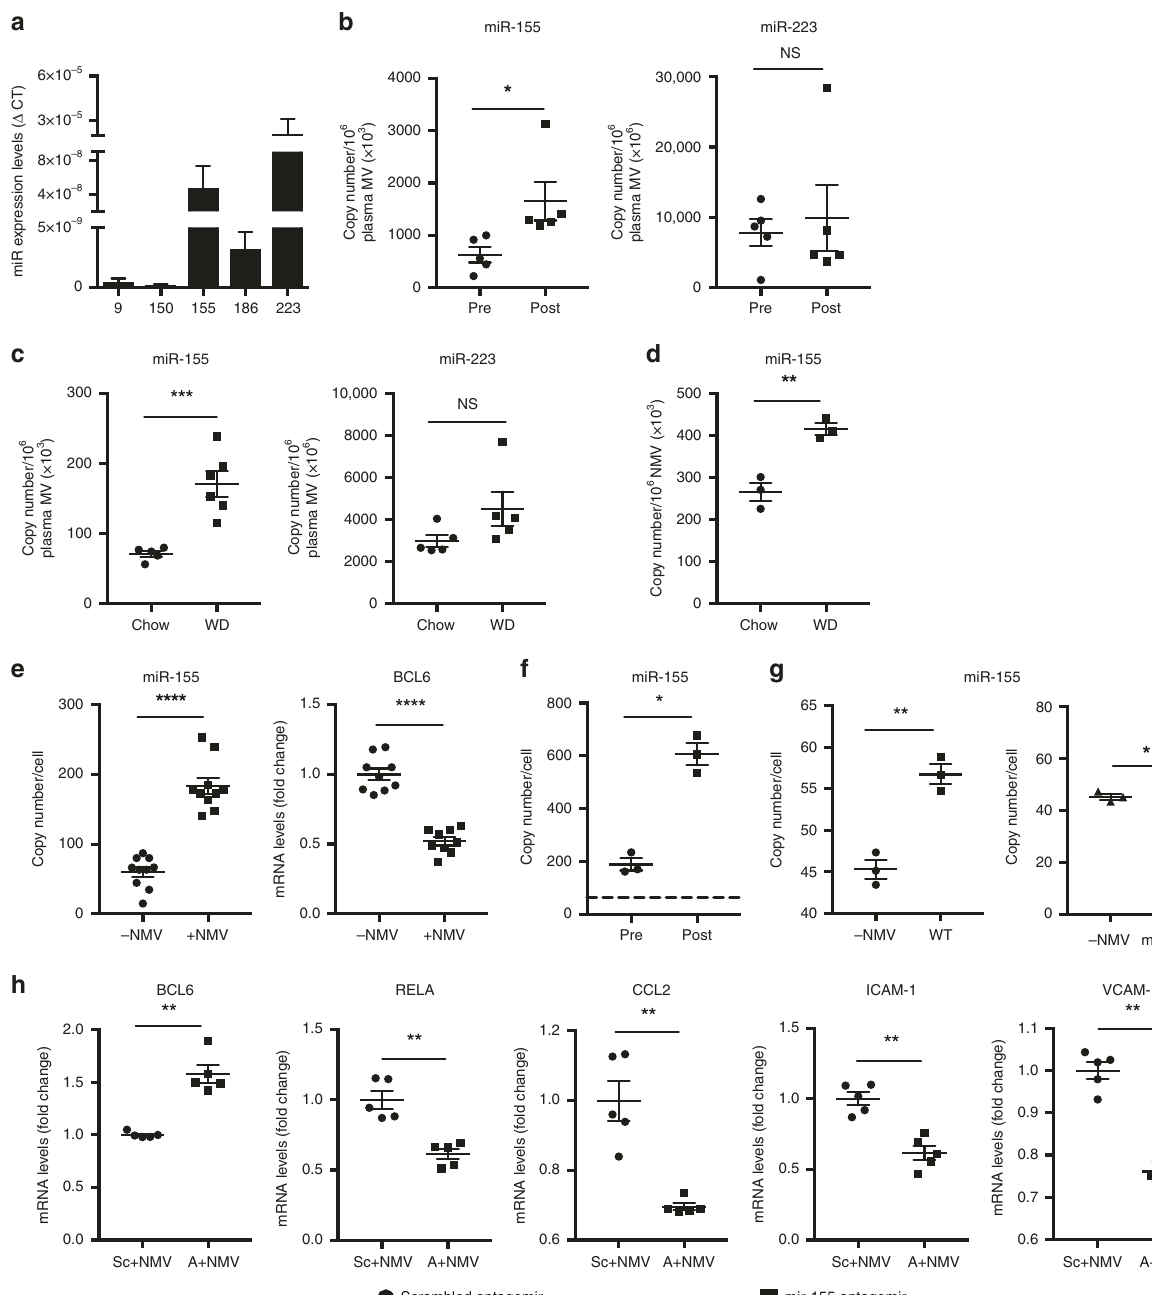
Fig. 6 NMVs contain miRNAs that are delivered to HCAEC and alter gene expression. a miRNA content of NMVs prepared from stimulated human neutrophils quanti fi ed by RT-qPCR ( n = 5). b miR-155 and miR-223 content of MVs in human plasma pre- and post high-fat diet (HFD, n = 5), or ( c ) plasma from mice fed chow or Western diet (WD, 6 weeks; n = 5) was quanti fi ed by RT-qPCR. d miR-155 expression levels in NMVs isolated from mice fed chow or Western diet ( n = 3) was measured by RT-qPCR. e HCAEC were incubated with ( + NMV) or without ( − NMV) NMVs for 2 h and miR-155 ( n = 10) and BCL6 ( n = 9) expression levels measured by RT-qPCR. f HCAEC were incubated with NMVs prepared from human neutrophils isolated pre- and post HFD and miR-155 expression levels quanti fi ed by RT-qPCR ( n = 3). The dotted line shows the mean copy number per HCAEC in the absence of NMVs. g HCAEC were incubated with NMVs prepared from miR-155 − / − vs. wild type mouse neutrophils and miR-155 expression levels quanti fi ed by RT-qPCR ( n = 3). h HCAEC were transfected with 25 ρ mol of miR-155 antagomir (A) or scrambled control (Sc) and incubated with NMVs for 2 h. HCAEC expression of BCL6 , RELA and its downstream targets was investigated by RT-qPCR ( n = 5). Data are presented as mean ± SEM and statistical signi fi cance evaluated using a paired or unpaired t -test as appropriate. NS not statistically signi fi cant, * P < 0.05, ** P < 0.01, *** P < 0.001, **** P < 0.0001. All n numbers represent independent experiments. Source data are provided as a Source Data fi